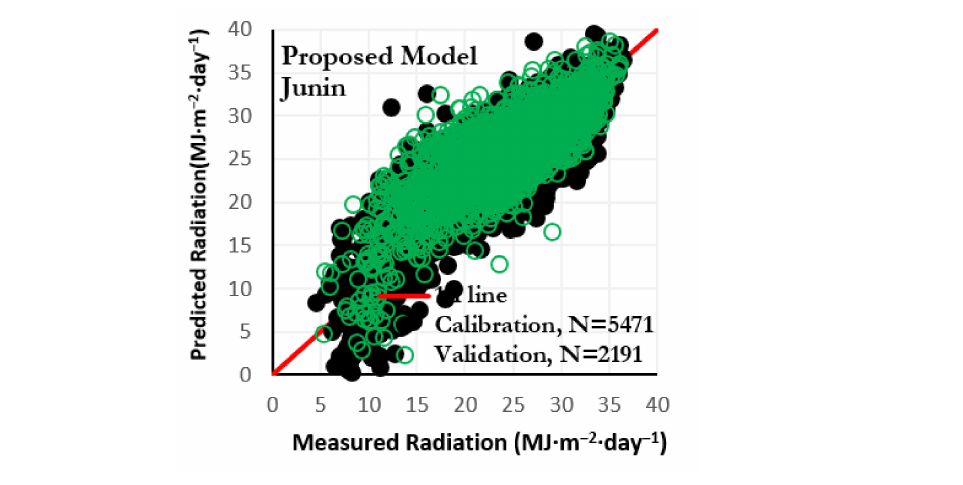
Figure 7. Solar radiation estimated by proposed model at Junin station versus measured values in calibration and validation sets.